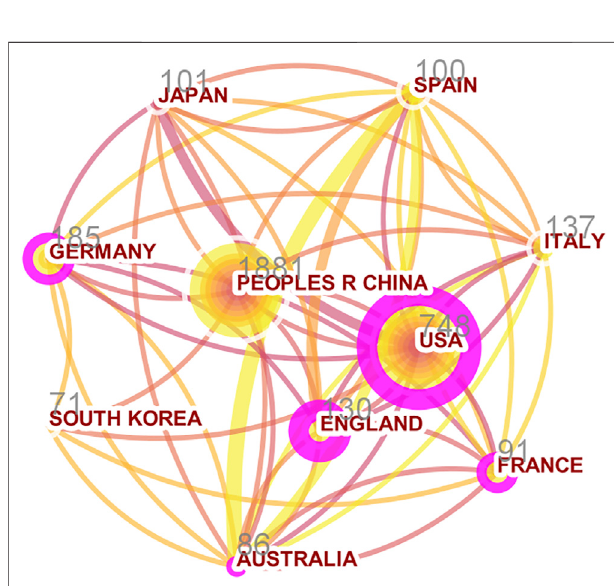
FIGURE3| Analysisofcooperationamongthetop10countries/regions with the highest documents. Footnote: The circumference of each node presents its number of documents, and the proportion of the outermost ring means its